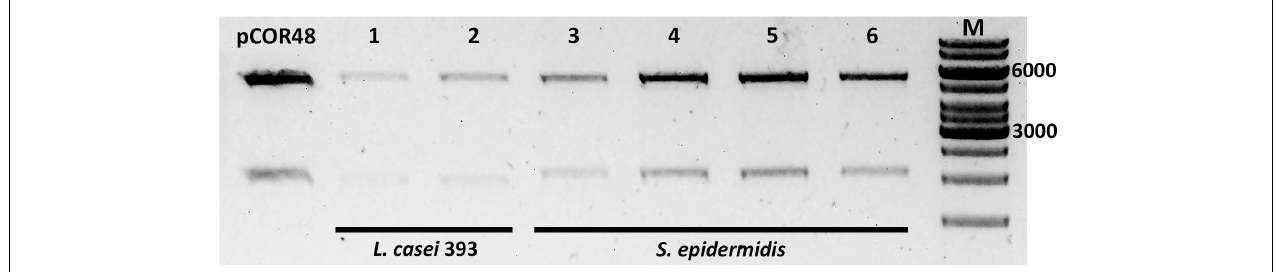
FIGURE 3 | Analysis of plasmids extracted from E. coli previously transformed with plasmid DNA from transconjugants. Plasmid DNA samples were digested with enzyme Eco RI (Fast Digest, Thermo Fisher Scientific), purified, and run on an agarose gel. pCOR48, plasmid DNA (positive control). The transconjugants from which the electroporated DNA was extracted were L. casei 393 (pCOR48) (1–2), and S. epidermidis (pCOR48) from two different colonies (3–4 and 5–6). M, molecular weight marker (GeneRuler 1 kb DNA ladder). The 6,000 and 3,000 bp are indicated. Expected fragment sizes: 5,436 and 2,000